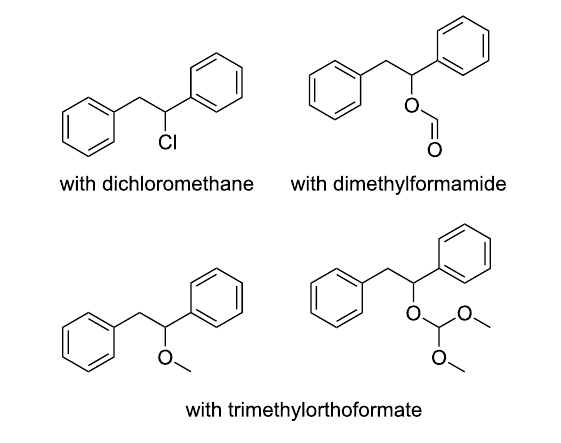
Figure 1: Products detected in the reaction mixtures during attempts to intercept the radical/cationic intermediate with various nucleophiles (solvents employed are